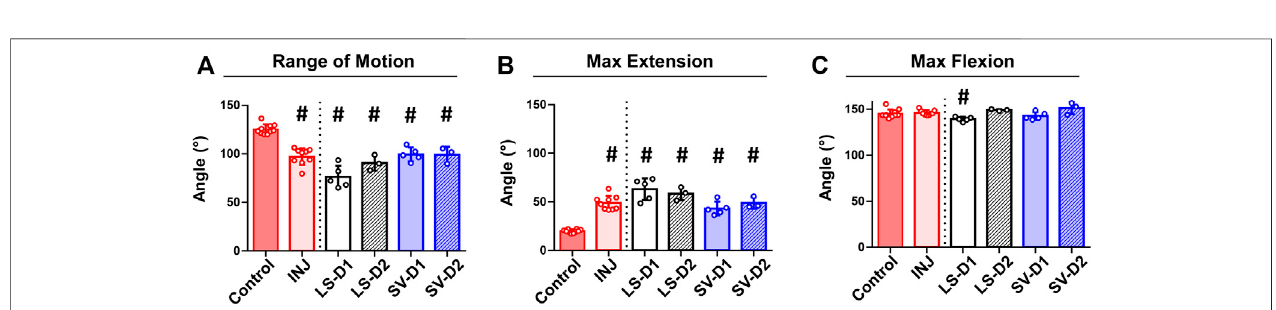
FIGURE 3 | No drug strategy prevented biomechanical measures of elbow contracture. Biomechanical parameters of decreased range of motion (A) and increased max extension (i.e., decreased elbow extension) (B) demonstrate signi fi cant elbow contracture in all groups compared to Control; no treatment strategy prevented or improved elbow contracture. Max fl exion (C) was largely unaffected by injury and treatment compared to Control. Results are shown as average ± SD; # indicates p < 0.05signi fi cantdifferencefromControl(oneway-ANOVAwithDunnett ’ spost-hoc).Note:Control (cid:1) uninjured,age-matched;INJ (cid:1) injurynodrug;LS- D1 (cid:1) losartan dosing strategy 1; LS-D2 (cid:1) losartan dosing strategy 2; SV-D1 (cid:1) simvastatin dosing strategy 1; and SV-D2 (cid:1) simvastatin dosing strategy